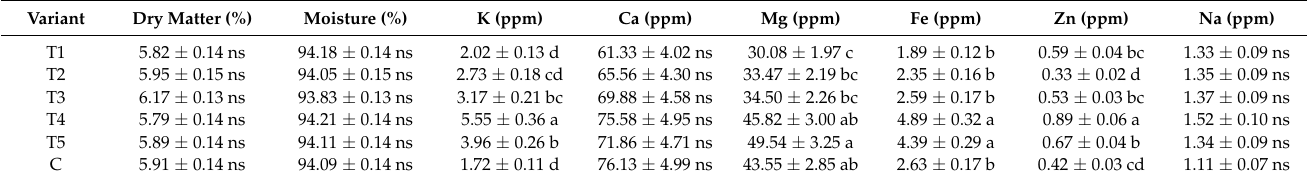
Table 8. The mineral content, dry matter and moisture of tomato